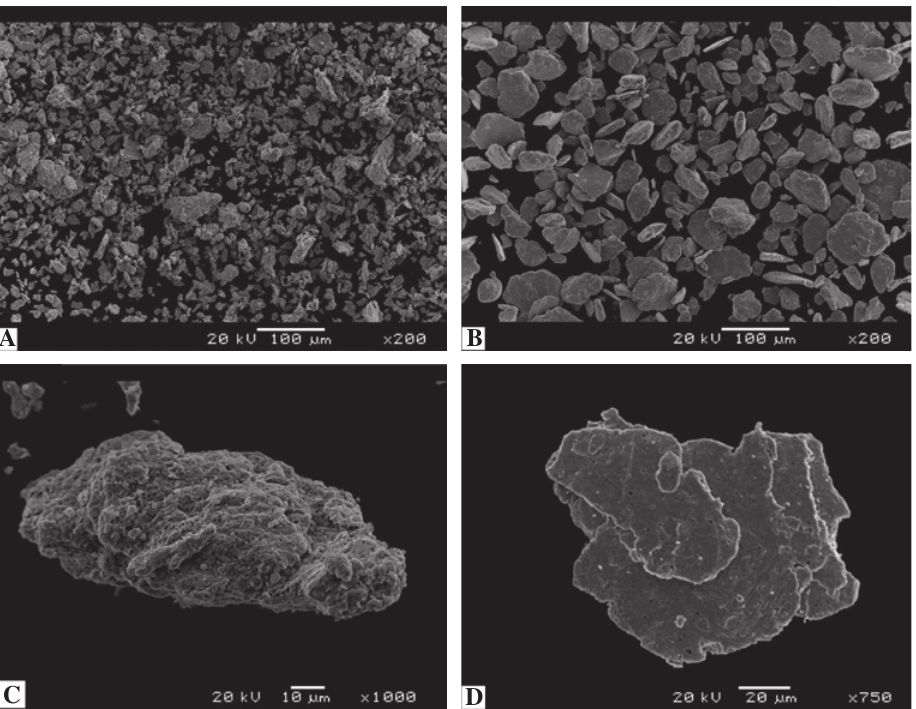
Figure 1 The shape and size of mechanically alloyed powders for different time periods, SEM photomicrographs: (A) 5 h, (B) 30 h, and SEM photomicrographs of particles with characteristic layers, (C) 5 h, (D) 30